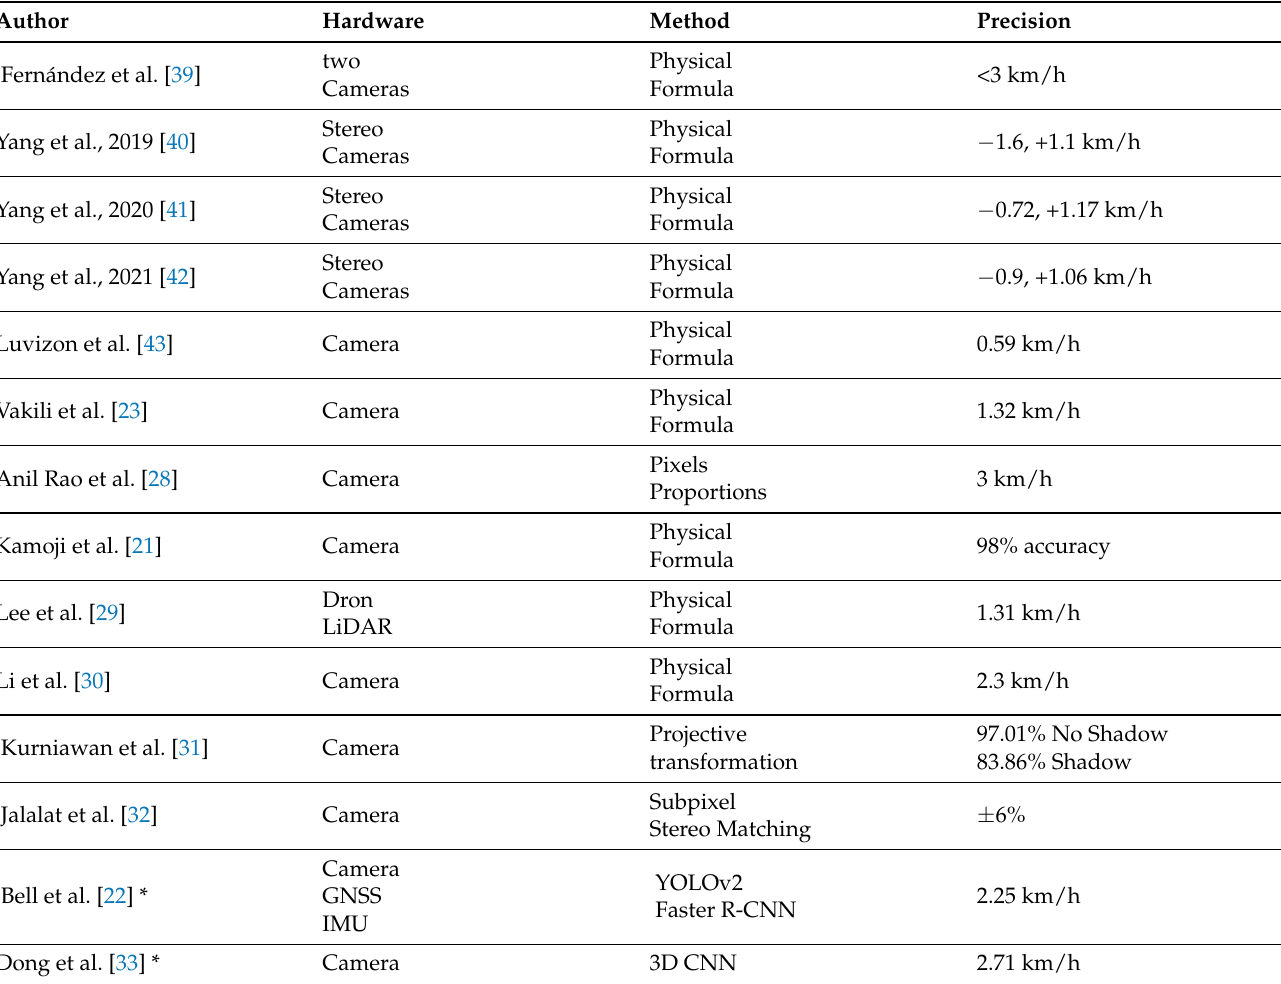
Table 1. State of the art summary. (* Machine learning